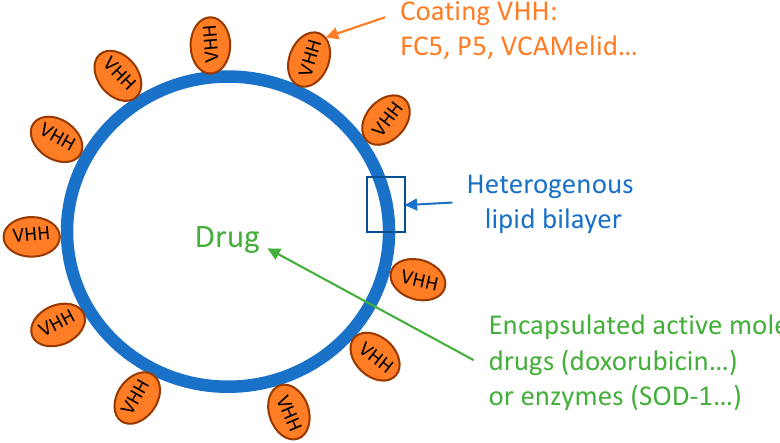
Figure 2. Encapsulated active molecule (drug or enzyme) into VHH-coated liposomes for brain delivery.